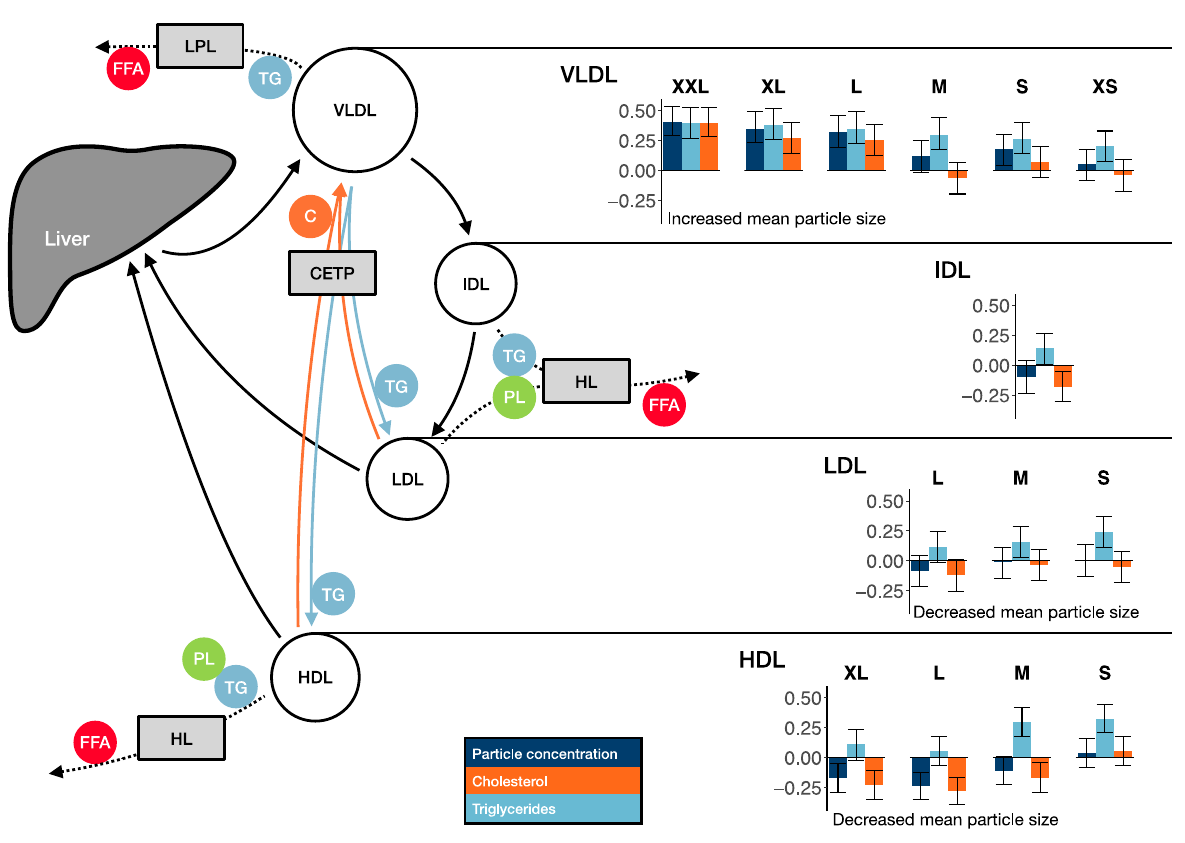
Figure 4. Lipoprotein metabolism and associations between insulin resistance and lipids in lipopro- tein subfractions. Very-low-density lipoproteins (VLDLs) are synthesized in the liver. Lipoprotein lipase (LPL) hydrolyzes triglycerides (TGs) in VLDLs to glycerol and free fatty acids (FFAs) to be stored in adipose tissue. VLDLs are transformed into intermediate density lipoproteins (IDLs) and subsequently into low-density lipoproteins (LDLs), which are metabolized in the liver. High-density lipoproteins (HDLs) transport cholesterol (C) from other tissues to liver. Cholesterol ester transfer protein (CETP) exchanges C and TG between LDL, HDL, and VLDL. Hepatic lipase (HL) hydrolyzes TG and phospholipids (PLs) in IDL, LDL, and HDL, hence promoting formation of smaller LDL and HDL particles. The associations between insulin resistance (HOMA2-IR) and particle concentration, C, and TG in different lipoprotein subfractions (XS–XXL) are shown as standardized regression co- efficients with 95% confidence intervals. Regression coefficients were adjusted for gestational age at sampling and maternal BMI class.